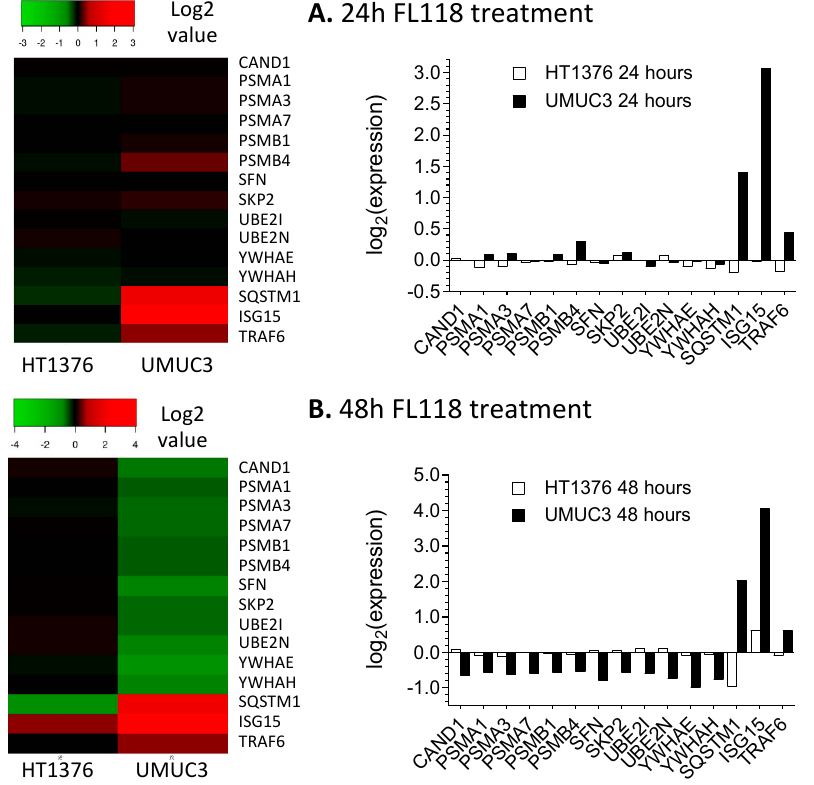
Figure 8. Effects of FL118 on Kras pathway-associated ubiquitination (Ub), de-Ub and proteasome- related proteins. HT1376 and UMUC3 cells were treated with FL118 (20 nM) for 24 h and 48 h.